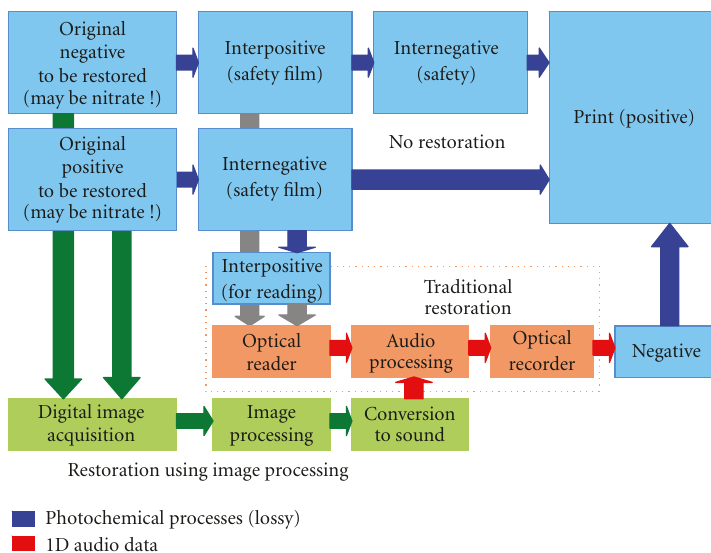
Figure 7: If the film to be restored is a positive, it may result from several intermediates—possibly including bad exposures. Nitrate film stock is often first copied on safety stock. Since a traditional optical pickup head cannot directly read negative, an interpositive is first printed. Digital processing can avoid such additional copy processes by digitizing the negative directly.